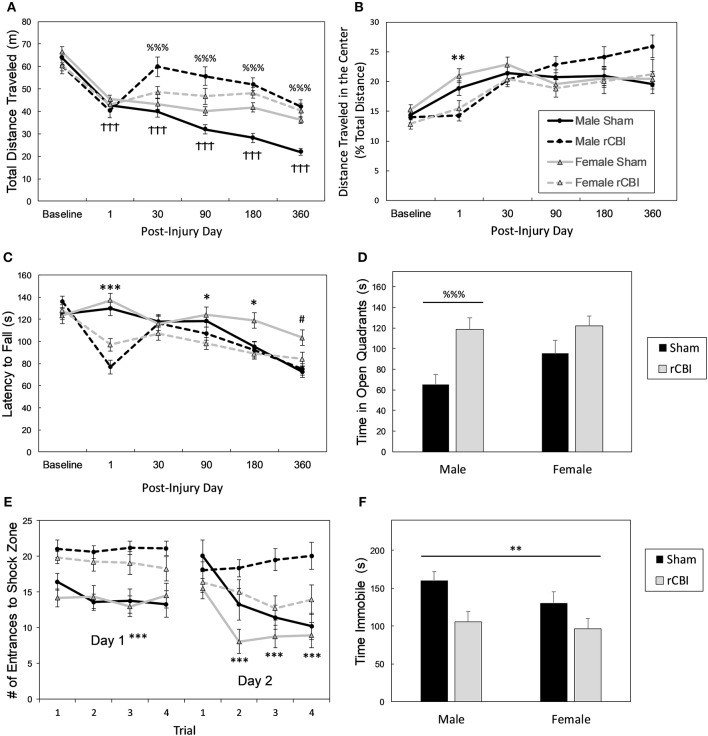
Chronic behavioral effects of rCBI. Legend in (B) applies to (A,B,C,E). Behavioral testing following rCBI revealed functional deficits in the OF (A,B), rotarod (C), EZM (D), APA (E), and TST (F) tests. Injured male mice began exhibiting a hyperactive phenotype in the OF about a month following injuries (A). All injured mice were significantly less active in the center zone of the OF the day following the final injury (expressed as a percentage of total activity), suggesting anxiety (B). On the rotarod (C), there were significant motor deficits the day following the injuries; slight impairment remained for up to 6 months. Only injured male mice had significantly different behavioral performance in the EZM (1 year; D); they spent increased time in the bright and exposed quadrants compared to sham-treated mice. One year post-injuries, all mice had significant cognitive deficits as assessed on the APA test (E), and showed significantly greater agitation (less immobility) in the TST for depressive behaviors (F). The cross signs († † †; p < 0.0001) in (A) indicate a significant effect of testing day in female mice; female mice became less active in the OF arena following baseline testing. The percent signs (%%% p < 0.0001) in (A,D) represent an injury effect in male mice only where Injured > Sham on the measured behavior. Asterisks (*p < 0.05, **p < 0.01 or ***p < 0.0001 in B,C,E,F) represent a main effect of injury on the given behavior (C: rCBI < Sham; E: rCBI > Sham); The pound sign (# p < 0.05) in (B,C,F) represents a main effect of sex (female > male). rCBI, repetitive concussive brain injury; OF, open field; EZM, elevated zero maze, APA, active place avoidance; TST, tail suspension test.